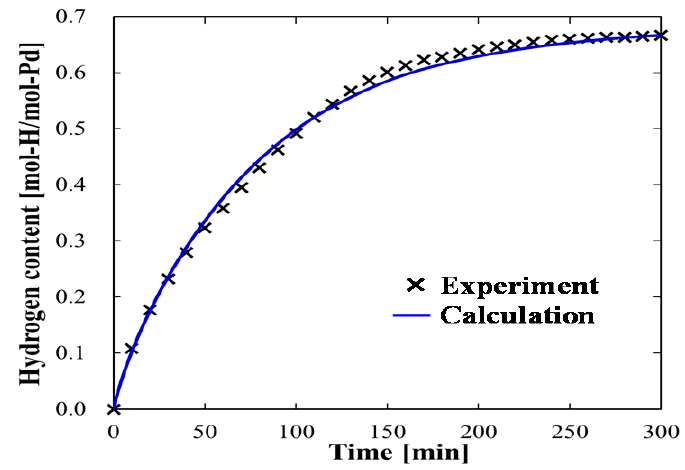
Figure 3. Experimental result and calculated fitted result of the time evolution of hydrogen content in Pd at 17 °C.